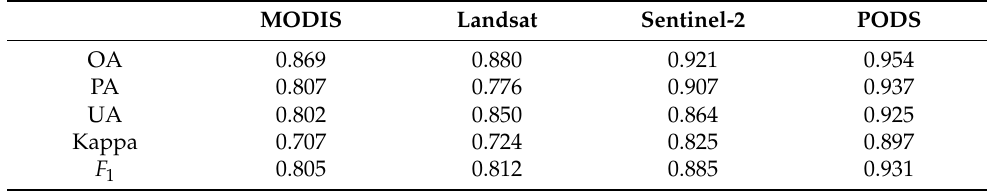
Figure 10. Comparison between three pixel-based classification results from MODIS, Landsat, and Sentinel-2 along with our results derived from PODS. The red is rice fields. ( a ) VHR reference image from Google Earth Engine, ( b ) 30-m Landsat 8 pixel-based result, ( c ) 250-m MODIS pixel-based result, ( d ) the reference rice fields, surrounded by cadastral boundaries (black), ( e ) 10-m Sentinel-2 pixel-based result, and ( f ) PODS object-oriented result. Table 3. Accuracy assessment of three pixel-based results from MODIS, Landsat-8 and Sentinel-2, and the object-oriented result generated by PODS.